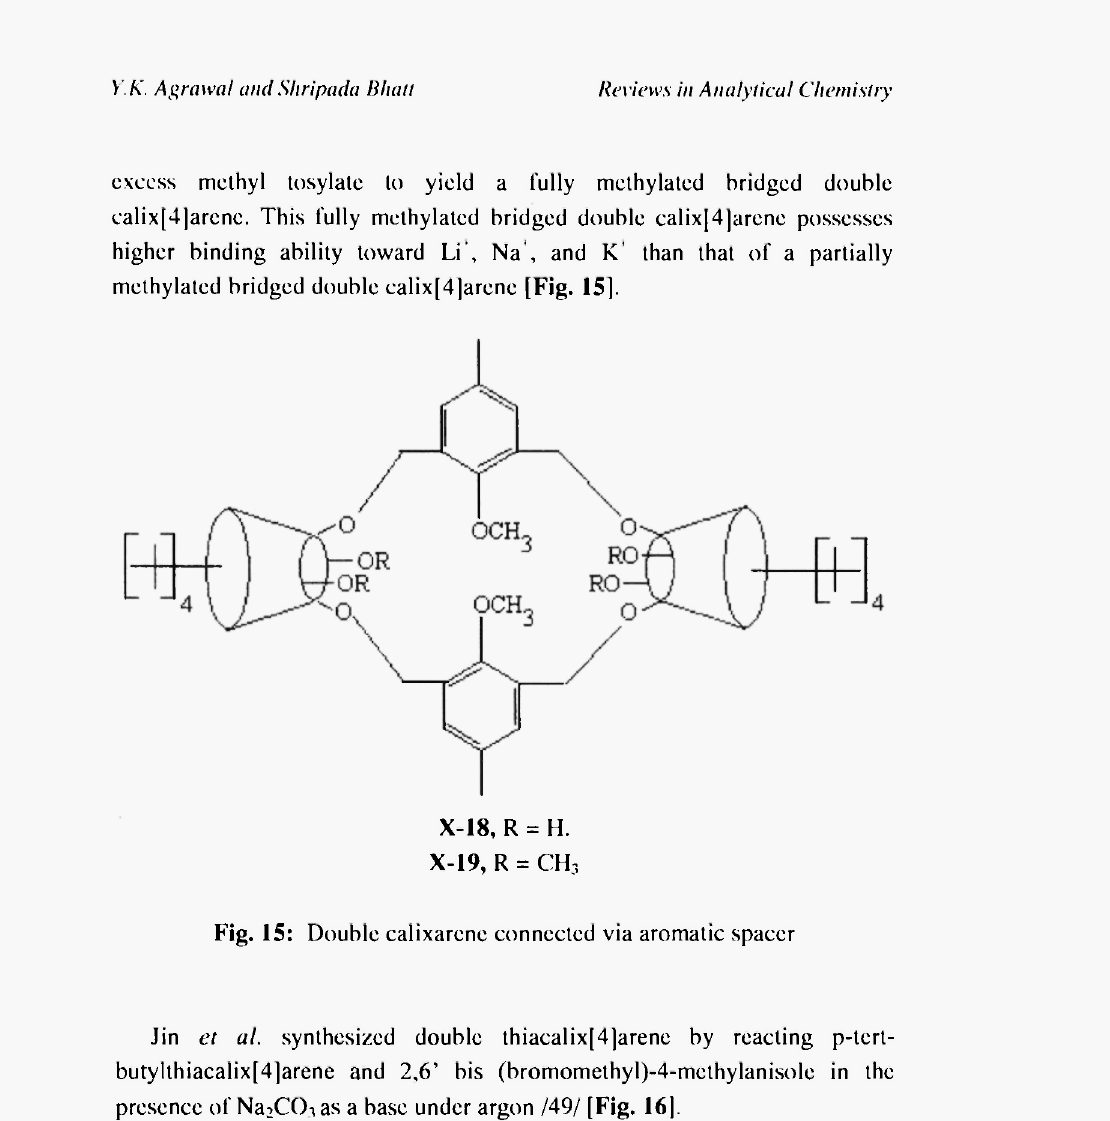
Jin et al. synthesized double thiacalix[4]arene by reacting p-tert- butylthiacalix[4]arene and 2,6' bis (bromomethyl)-4-methylanisole in the presence of Na 2 COi as a base under argon /49/ [Fig.